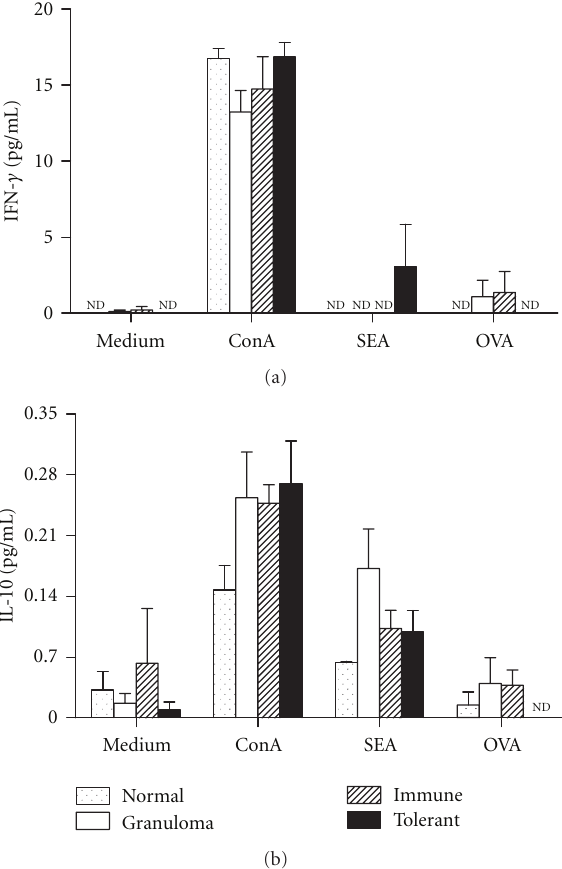
Figure 8: IFN- γ and IL-10 production of spleen cells stimulated with SEA or OVA. Eighteen days after i.v. injection of S. mansoni eggs in nonimmunized mice (granuloma group, open bars), OVA immune controls (hatched bars), and OVA-orally tolerant mice (black bars) spleen cells were cultured with medium, ConA, SEA or OVA for 3 days. Normal mice (doted bars) were not immunized with OVA neither injected with eggs. The culture supernatant fluids were harvested and IFN- γ and IL-10 measured by sandwich ELISA. The results are shown as mean concentrations ± SEM. nd: not